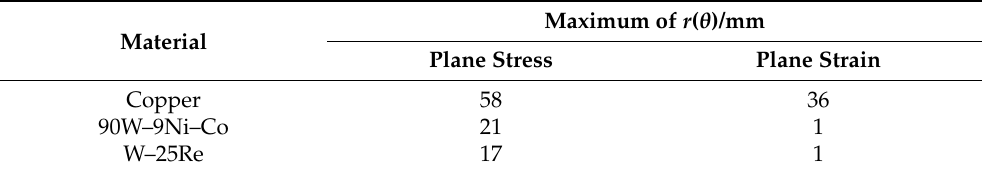
Table 10. The maximum of r ( θ ) for the three kinds of